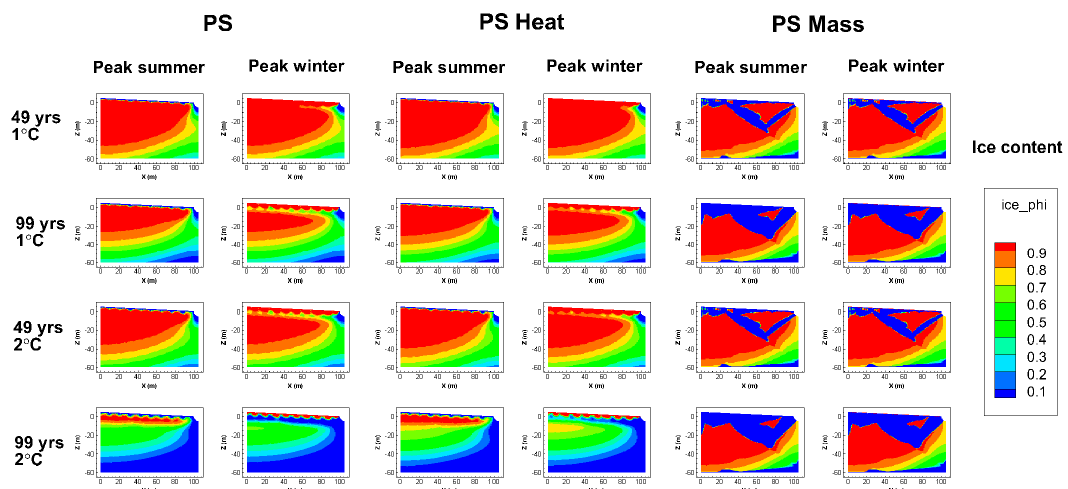
Figure A4. Detailed ice content results for the simulation cases of no soil (NS, upper set of panels), mineral soil (MS, middle set of panels), and peat soil (PS, lower set of panels) in peak summer and peak winter at different times (after 49 and 99 years) of the two temperature increase scenarios (1 °C and 2 °C over 100 years) with different heat transport accounts, where “Heat” stands for only heat conduction and “Mass” stands for only convection–advection being active in the simulations.